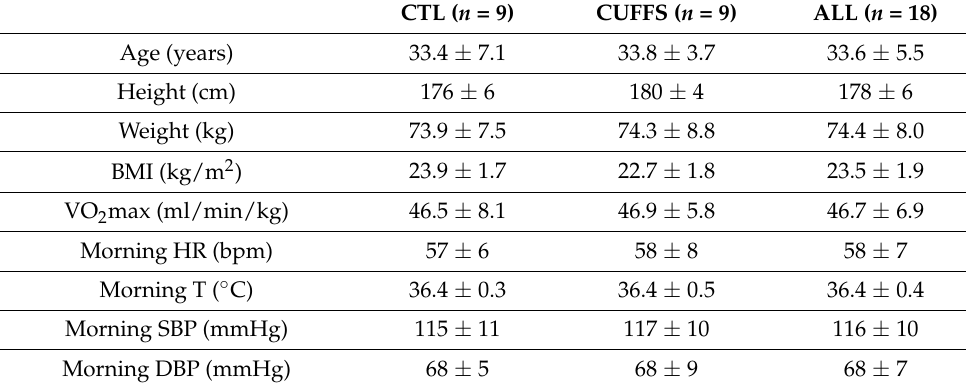
Table 1. Baseline characteristics at day 2 before DI initiation